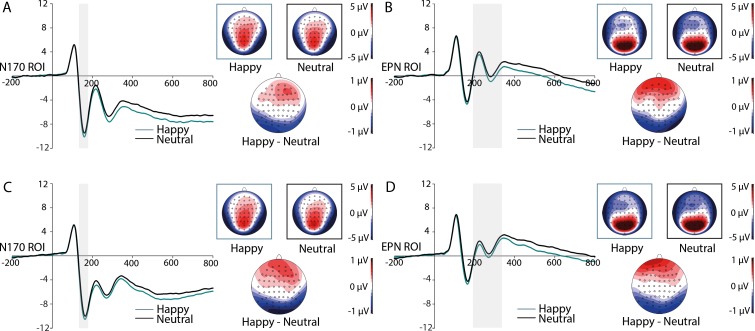
Grand-averaged ERPs at N170-ROI electrodes.ERPs contrasted for happy and neutral faces during the learning (A) and consolidation phase (C) with corresponding scalp distributions and topographies of ERP differences between indicated emotion categories. Grand-averaged ERPs at EPN-ROI electrodes for happy and neutral faces during the learning (B) and consolidation phase (D) with corresponding scalp distributions and topographies of ERP differences between indicated emotion categories. Highlighted areas display the time windows of ERP analyses.